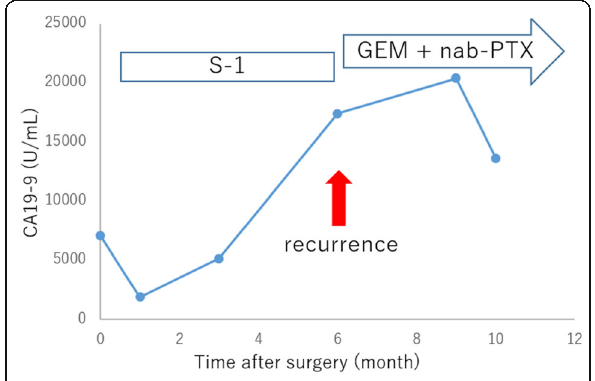
Fig. 4 Changes in serum carbohydrate antigen 19 – 9 (CA19-9) level associated with postoperative chemotherapy in case 1. CA19-9 level of postoperative month 0 shown in the graph indicates